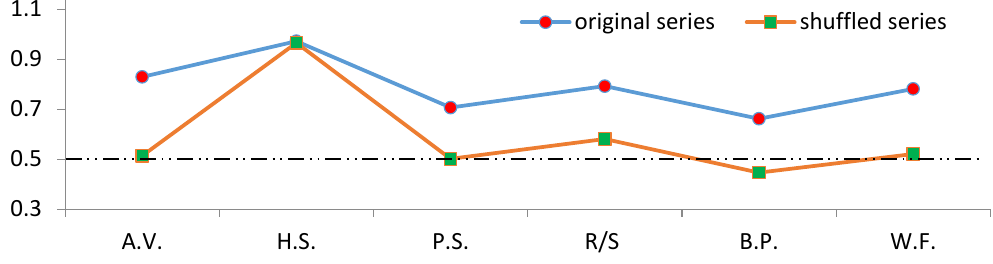
Figure 5. Original and shuffled series’ scaling exponent test results.